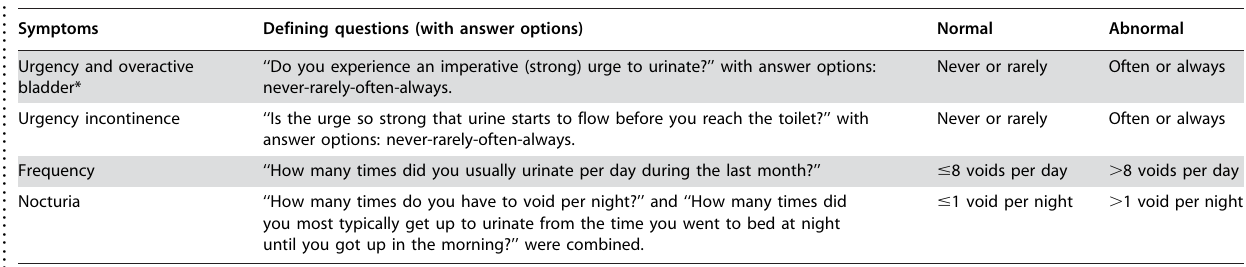
Table 1. Overactive bladder symptom-related questions and definitions of the study in Finland, 2003–2004 .. ... .... ... ... .... ... ... .... ... ... .... ... ... .... ... ... .... ... ... .... ... ... .... ... ... .... ... ... .... ... ... .... ... ... .... ... ... .... ... ... .... ... ... .